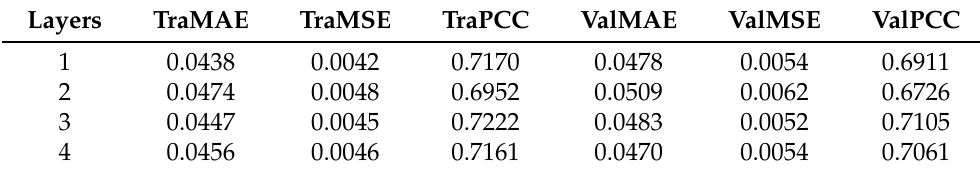
Table 3. Effect of FCNN layers on model performance when the SEB-RB blocks are 12.